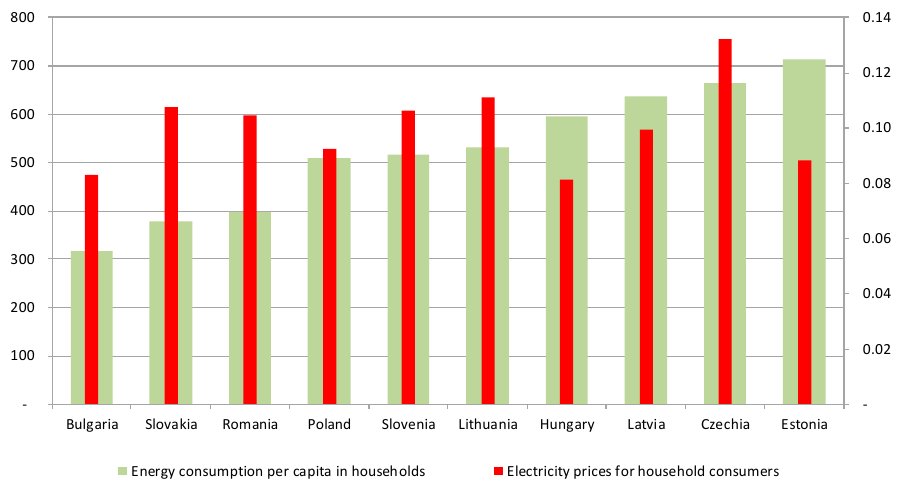
Figure 5. Electricity prices and energy consumption per capita in households in CEE countries in 2020.